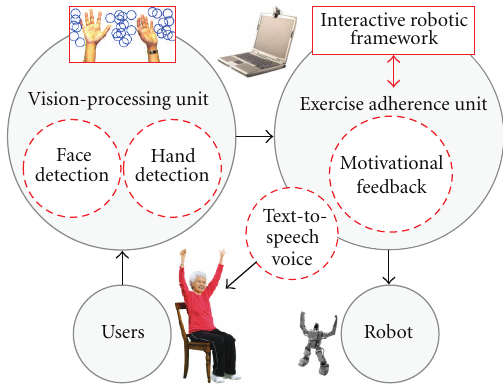
Figure 2: Information flows from the vision-processing unit, which monitors the user’s movements, to the exercise adherence unit. The exercise adherence unit controls the robot’s performance of each exercise move and, after the user completes (or fails to complete) the move, reports the adherence assessment. The interactive framework used in this study is shown in Figure